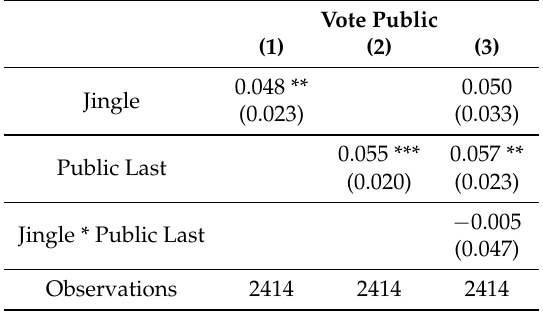
Table A1. Jingle and recency effects in individual sessions. The dependent variable is a dummy variable equal to 1 when public and private signals differ, and the subject votes according to the public signal, 0 otherwise. The variable Jingle is a dummy variable equal to 1 when the public information is displayed with a salient video, and the variable Public last is a dummy variable equal to 1 when the public signal is displayed before the private signal. Column (3) shows that when controlling for order effects, the effect of the jingle is not significant anymore. Standard errors are clustered at the individual level in parenthesis. * corresponds to p < 0.1, ** to p < 0.05, and *** to p < 0.01. Vote Public (1) (2) (3) 0.048 ** 0.050 Jingle (0.023) (0.033) 0.055 *** 0.057 ** Public Last (0.020) (0.023) − 0.005